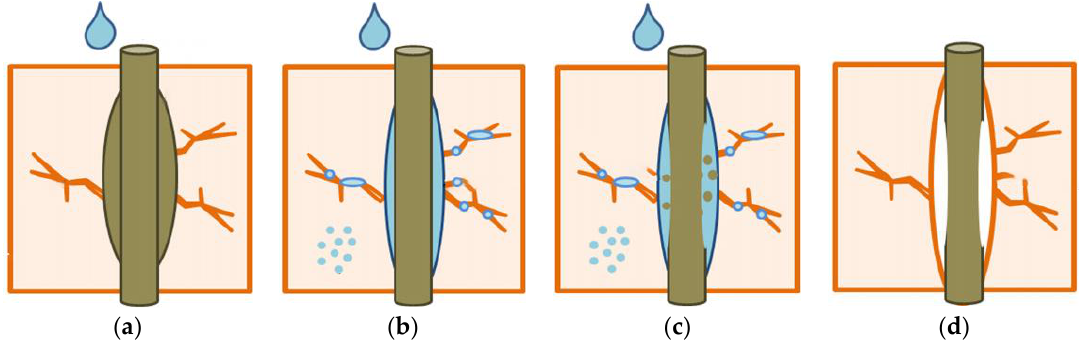
Figure 1. The degradation of interfacial adhesion due to moisture absorption: ( a ) development of micro-cracks due to expansion of swollen fiber, ( b ) water molecules diffused in the bulk matrix flow along the fiber–matrix interface, ( c ) water-soluble components leach from fiber, ( d ) ultimate matrix–fiber debonding takes place. Reproduced with permission from [18].